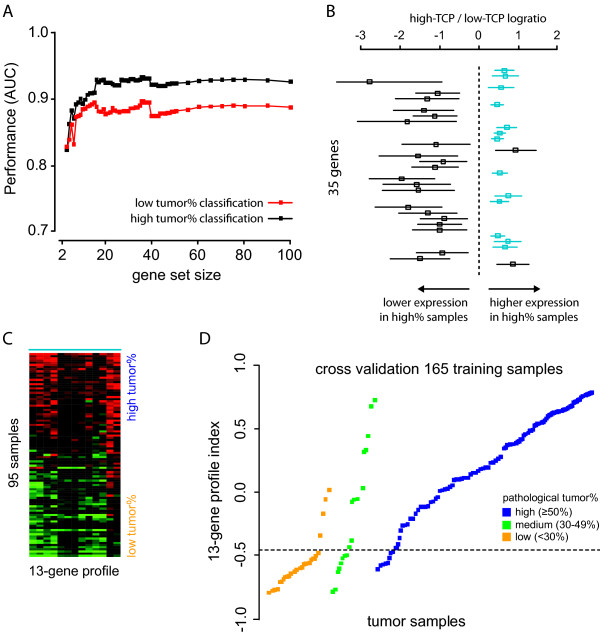
Identification of a tumour percentage transcriptional profile. (A) Classifier performance (area under ROC curve) using different top-ranked gene set sizes. Performance is given for classification of low (<30%) and high (≥50%) TCP samples. (B) Differential gene expression of top 35 ranked genes between low and high TCP samples. Bars represent expression variation of each gene across 70 high TCP samples. Thirteen most stably differential expressed genes for high TCP are indicated in blue. (C) Heat-map of the 13-gene tumour percentage profile for 95 training samples. Samples are ordered according to their pathologist scored tumour percentage. (D) Profile outcome for all 165 training samples. Profile indexes are calculated using a leave-one-out CV. Tumour samples are grouped according to their tumour percent scoring and ordered according to the profile index. Horizontal dashed line represents the optimal classification threshold.